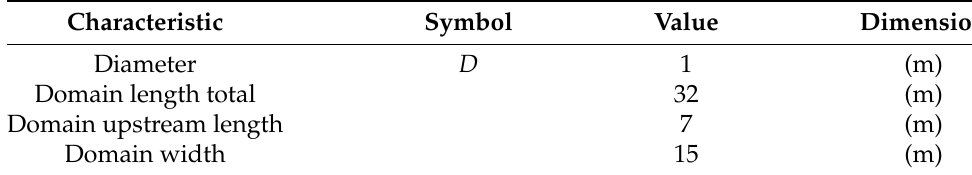
Figure 3. Schematic of the computational domain. Table 4. Details on the computational domain considered.